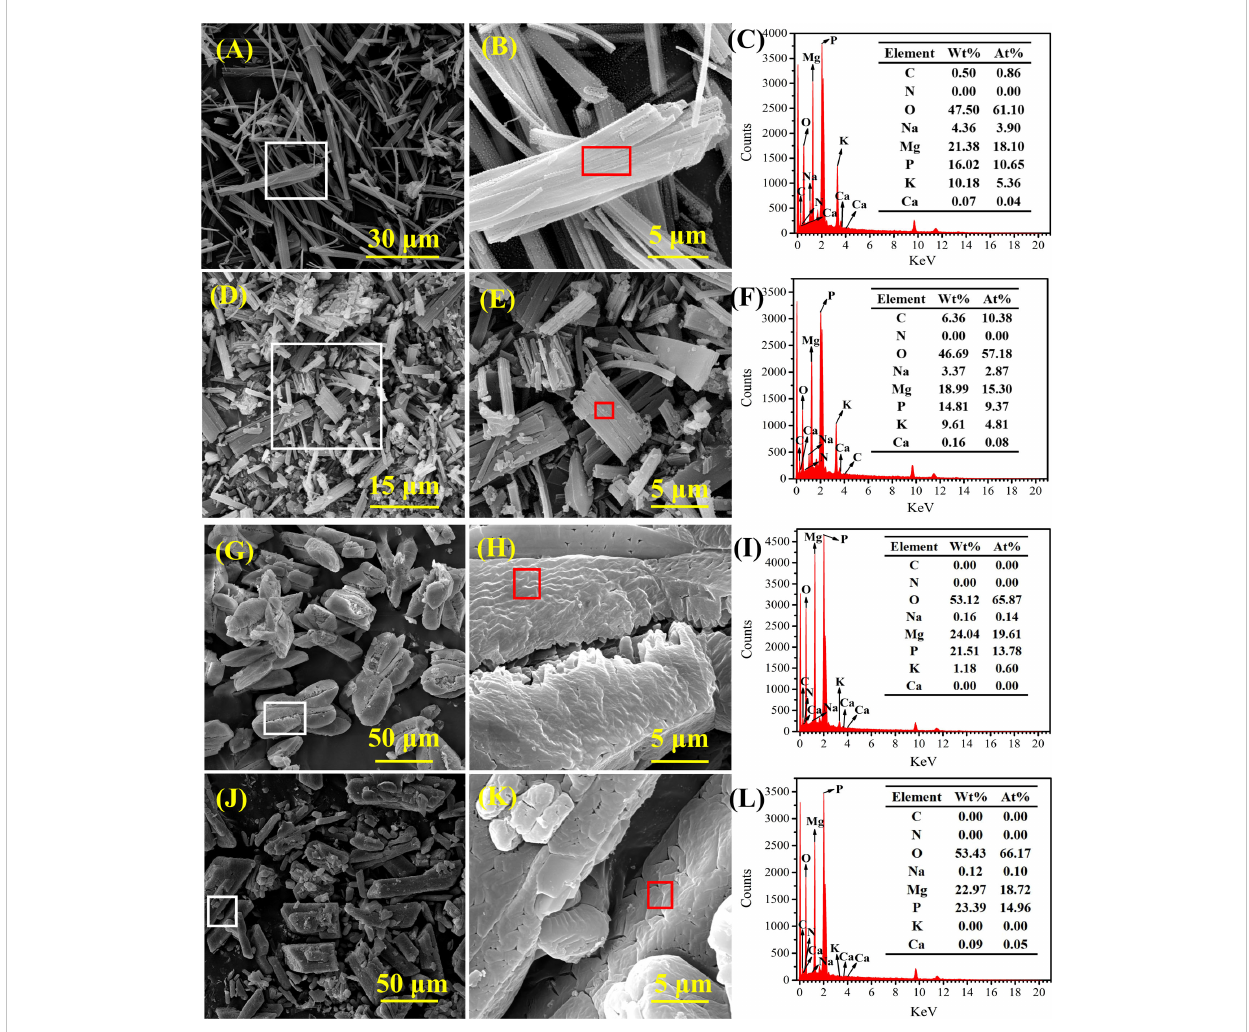
FIGURE 4 Scanning electron microscope (SEM) and energy dispersive spectrum (EDS) images of mineral crystals induced by strains A. alteriprofundi HHU 13199 T (A – C) , A. alterisediminis N102 T (D – F) , ammonia solution (G – I) , and commercial struvite standard (NH 4 MgPO 4 ·6H 2 O) (J – L) ,